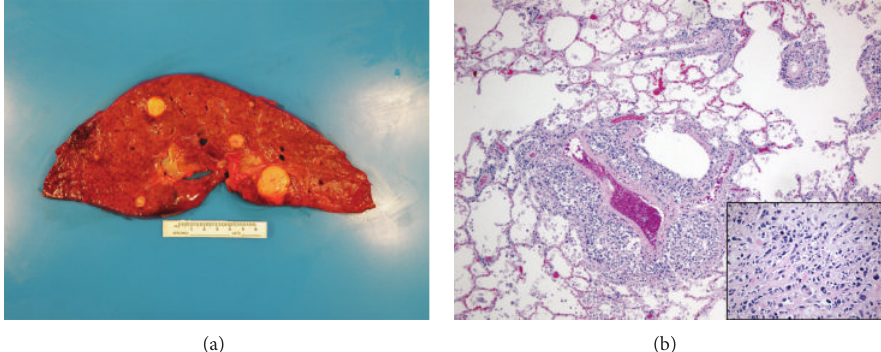
Figure 2: Disseminated disease at necropsy. (a) Cross-section of liver demonstrating metastatic nodules. (b) Histological section of lung with metastatic sclerosing rhabdomyosarcoma. Hematoxylin-eosin, insert original magnifications × 200. Table 1: Summary of reported cytogenetic abnormalities in sclerosing rhabdomyosarcoma.